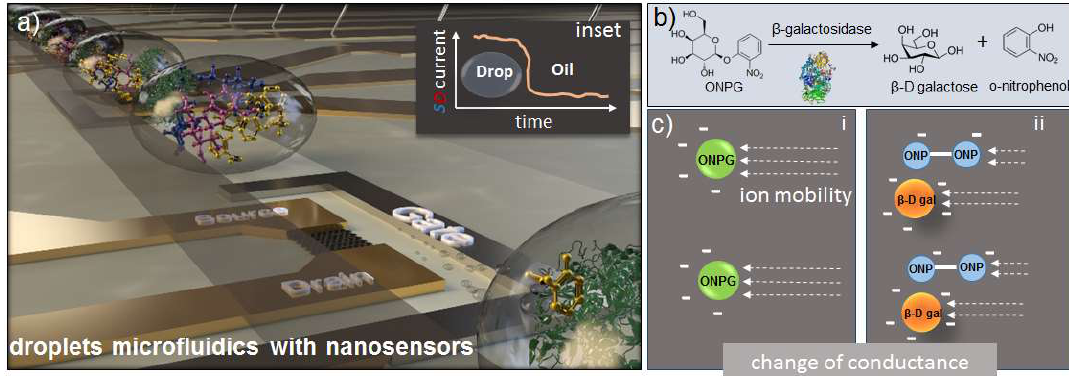
Figure 1. Concept of the work. ( a ) Schematic of the platform comprising a field-effect transistor chip as a sensor and a droplet microfluidics flow-cell as a sample delivery module. ( b ) The enzymatic reaction of β-galactosidase and ortho-nitrophenyl-β-galactoside (ONPG). ( c ) Ionic composition before and after the reaction, the arrows represent ion mobility. Field-effect transistor (FET) devices are located directly under the microfluidic channel allowing the detection of droplets one-by-one upon passing. Droplets act as a modulating liquid gate that leads to the tuning of the FET source and drain current.